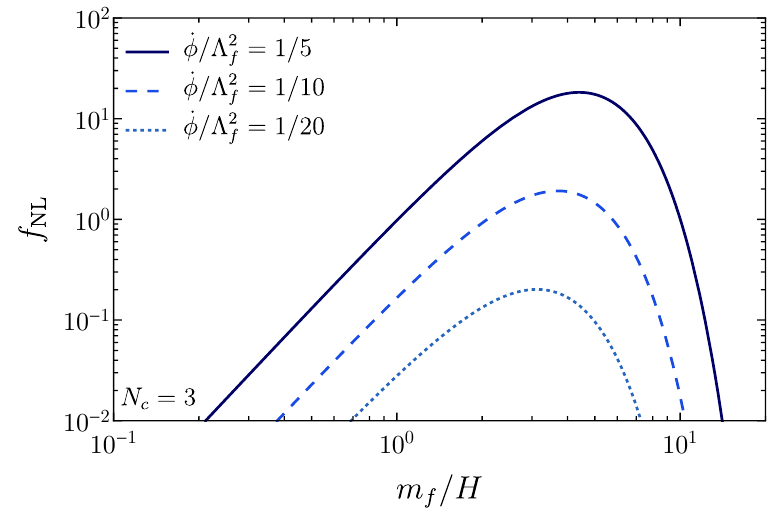
Figure 5 . The signal strength due to a single Dirac fermion as a function of the fermion mass in Hubble units. The solid, dashed and dotted blue lines show f NL for di(cid:11)erent values of _ (cid:30)= (cid:3) 2 The signal strength increases as m 3 in the small mass limit and decreases exponentially when ( m=H ) 2 becomes larger than _ (cid:30) (cid:3) f H